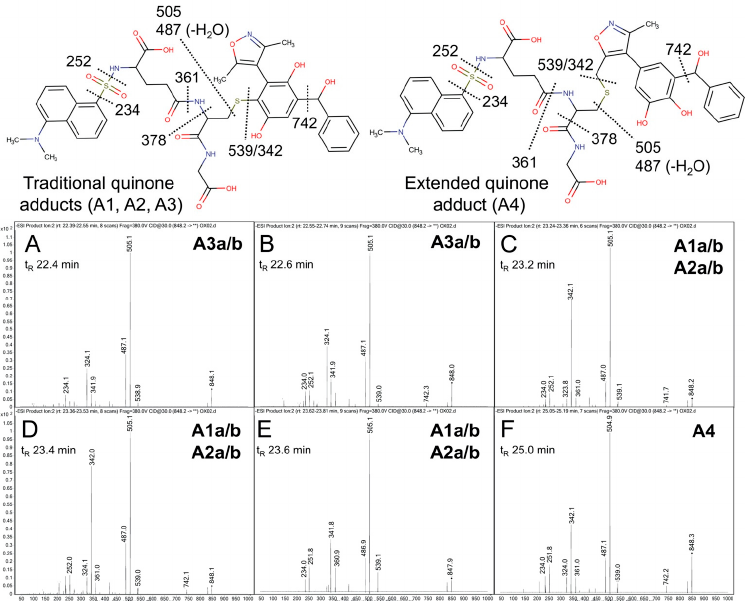
Figure 5 . Mass spectrometric product ion spectra for predicted quinone metabolite adducts for OXFBD02. The results show the integrated spectra and product ion fragments for peaks eluting in a 2:3:1 ratio based on intensity in Figure 4A. Characteristic dansyl glutathione fragments m / z 234, 252, 361, 378, 487, 505, and 539 have been reported previously in negative ion mode by Gan and colleagues [54,55]. The site of hydroxylation did not impact the observed fragment patterns. Assignments for the respective fragments are indicated in the accompanying molecular structures for the corresponding adducts. Peak assignments for adducts (Figure 3) are discussed in detail under Results. ( A , B ) shows spectra for the prob- able pair of adduct isomers (A3a/b) from a traditional quinone in Pathway 3 (Q3). ( C – E ) depict the unresolved pairs of adduct isomers from Pathway 1 (A1a/b) and Pathway 2 (A2a/b). Finally, spectra for the last eluting peak ( F ) corresponds to the adduct (A4) from the extended quinone methide (EQ) in Pathway 2.